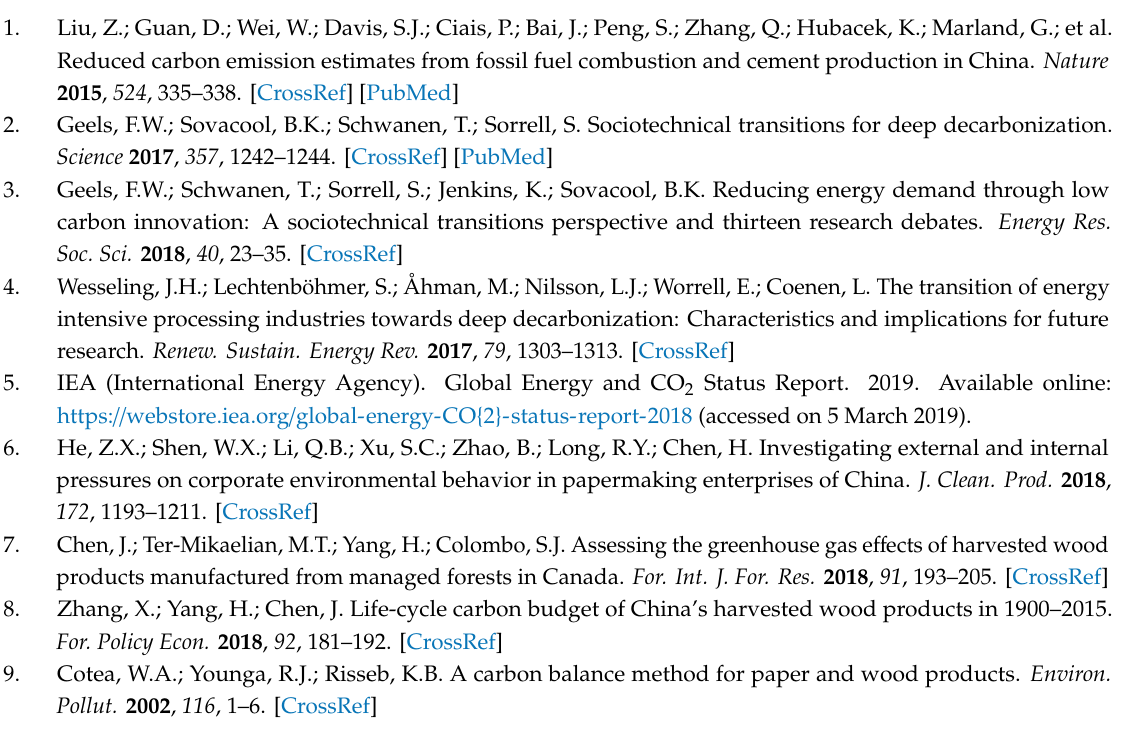
Table S1: Energy consumption intensity table of major production processes, Table S2: Energy supply and conversion parameters in the forestry pulp and paper industry, Table S3: Carbon content of materials, Table S4: Conversion ratio parameters of materials in the supply chain, Table S5: Proportions of raw materials for high-grade packaging cardboard, Table S6: Main raw materials of high-grade writing paper, Table S7: Main raw materials of coated paper, Table S8: Boiler performance parameters, Table S9: Turbine generator set performance parameters, Table S10: Main production workshop heat load parameters, Table S11: Energy value and boiler combustion e ffi ciency, Table S12: Carbon emissions parameters of raw materials, Table S13: Global warming potential of greenhouse gases for 100 years, Table S14: Emission